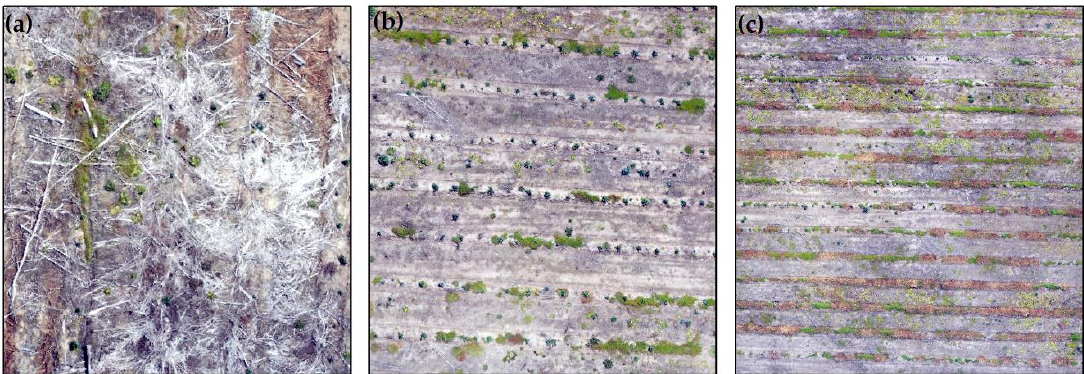
Figure 2 . The level of noise in three different plantation compartments: ( a ) compartment-A is dominated by dead plant background noise; ( b ) compartment-B is fairly clean from dead plants and wild species dominating by soil; ( c ) and compartment-C is subject to the background noise of wild species.